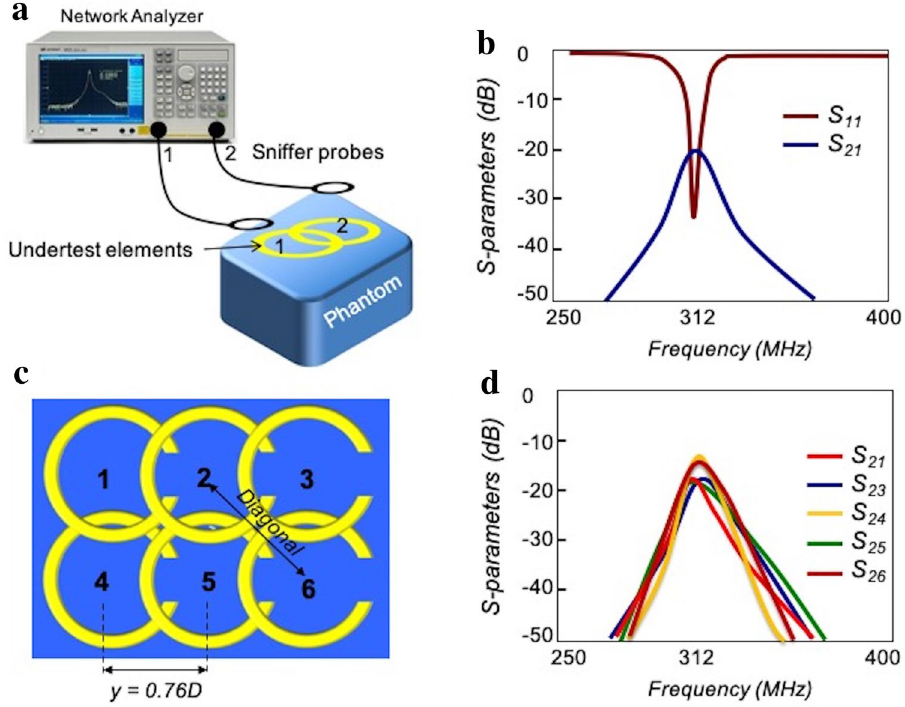
Figure 5. Bench-top test. ( a ) Bench test setup to measure the coupling between two resonators. ( b ) Measured S-parameters for two decoupled resonators. S21 shows about − 20 dB decoupling level, the symmetric behavior of S11 around f 0 = 312 MHz also proves the fact. ( c ) All the inline elements were separated by critical overlapping technique. Diagonal elements are slightly coupled due to their geometrical positions. ( d ) Measured S-parameters show the coupling values of the resonator number 2 with three others inline neighbouring (1, 3, and 5) and diagonal (4 and 6) resonators. Measured S21, S23, and S25 show coupling values below − 16 dB, while S24 and S26 show coupling value about -14